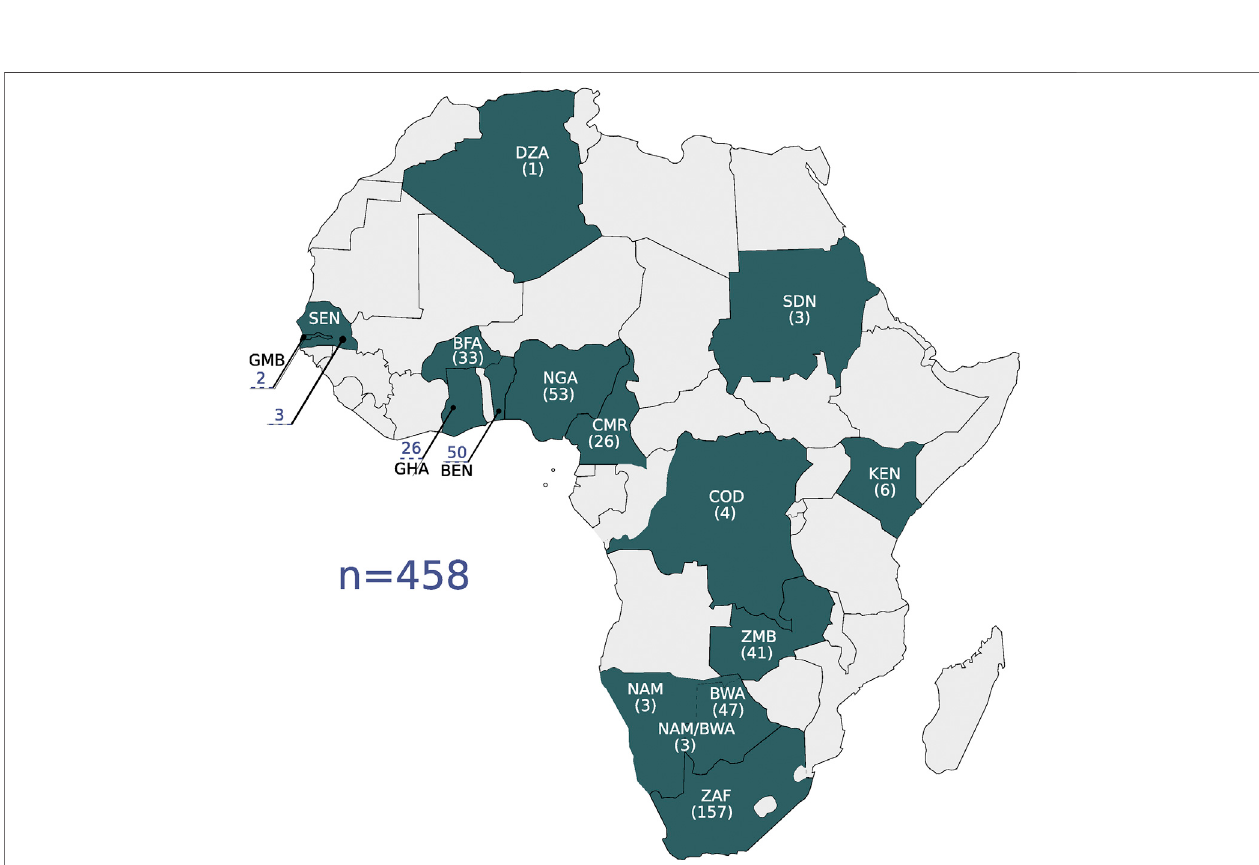
FIGURE 1 | The geographic locations of the high coverage WGS data are shown on the map. Countries are referenced by their ISO 3166-1 alpha-3 code: BEN, Benin;BFA,BurkinaFaso;BWA,Botswana;CMR,Cameroon;COD,DemocraticRepublicoftheCongo;DZA,Algeria;GHA,Ghana;GMB,Gambia;KEN,Kenya;NAM, Namibia; NGA, Nigeria; SDN, Sudan; SEN, Senegal; ZAF, South Africa; ZMB, Zambia. The number of samples per country is shown in parentheses.